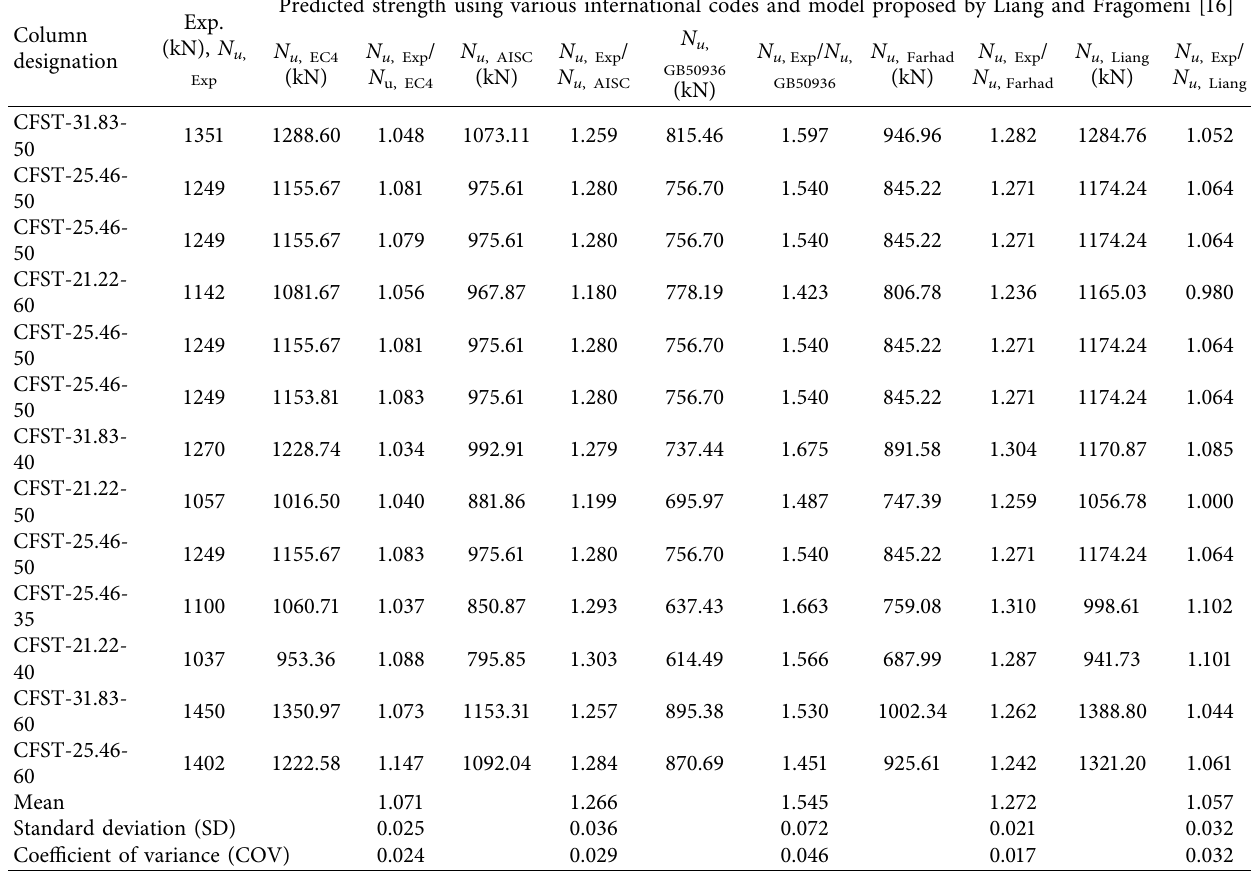
Table 4: Validation of test results with various International codes and model proposed in [6,